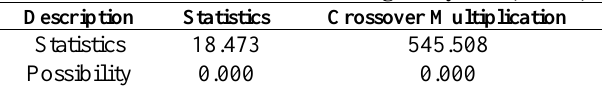
Table 4. Results of variance heterogeneity test